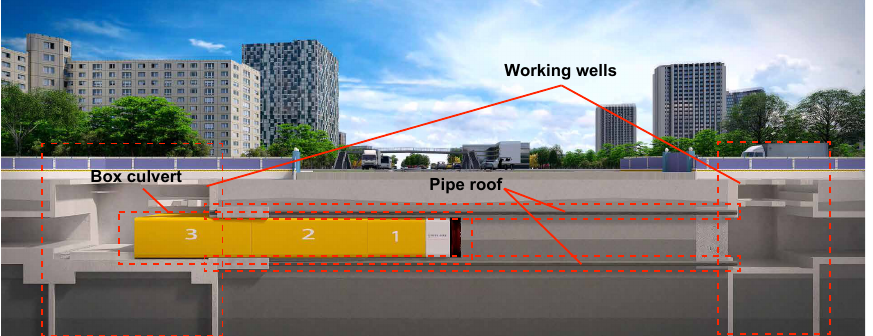
Figure 1. Illustration of the Roof-Box Jacking Method (RBJ).